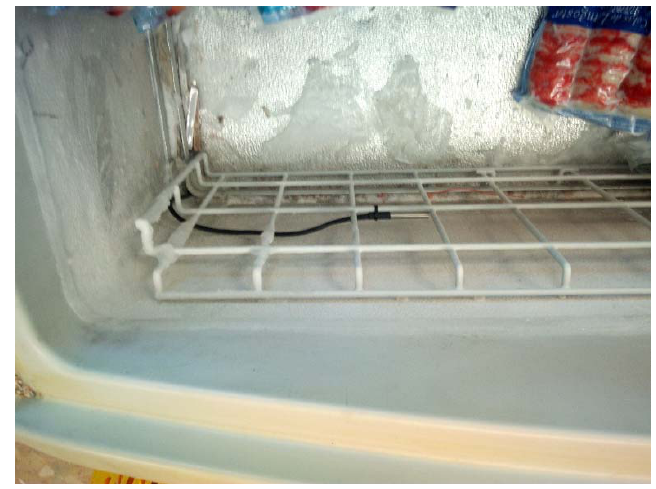
Figure 7. DS18B20 probe placed in a freezer for the experimental setup.